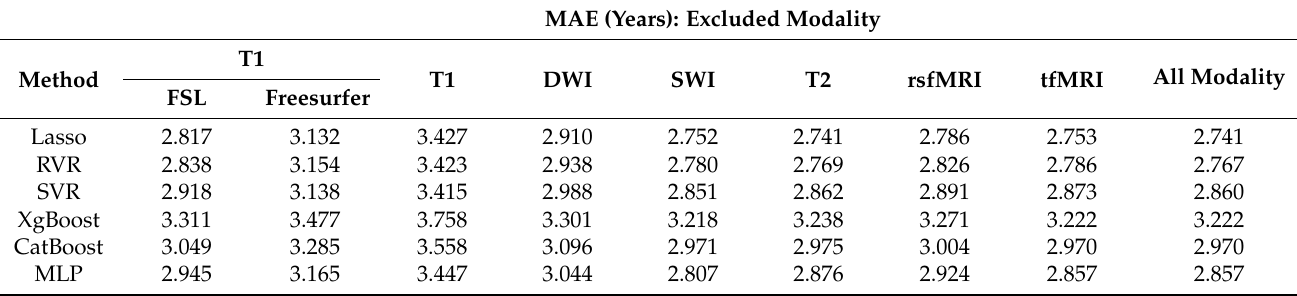
Table 5. Brain age prediction performance, leaving out single modality.